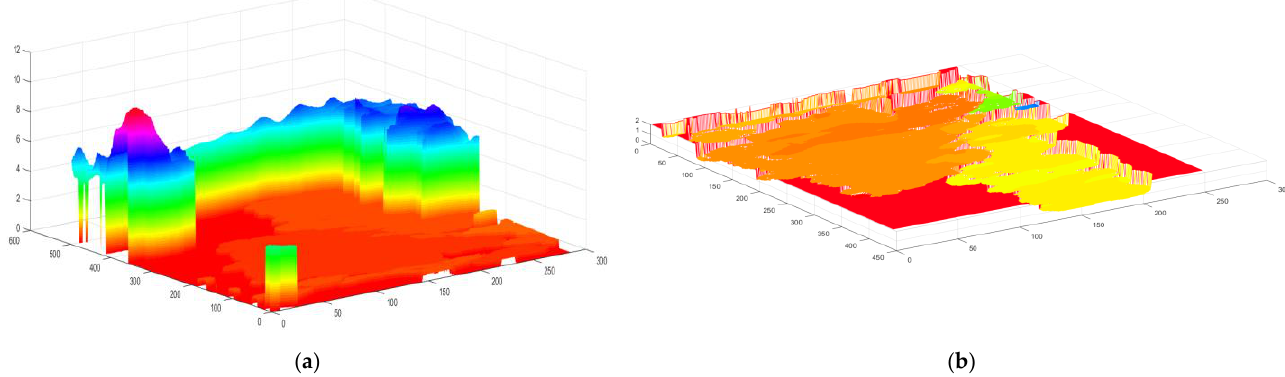
Figure 9. The preprocessing of the original depth image. ( a ) Original depth data, and ( b ) the preprocessed depth data.